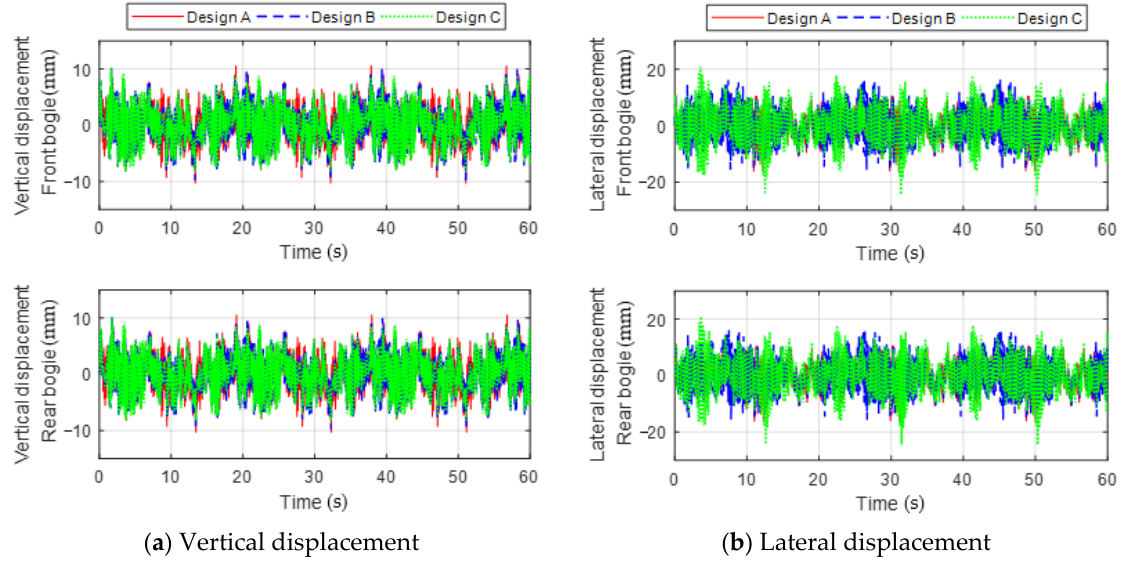
Figure 19. Vertical and lateral displacements of the front and rear bogies at a speed of 600 km/h.